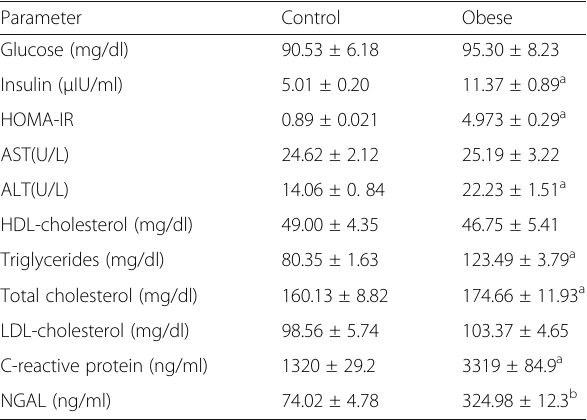
Table 2 Comparison of laboratory data between control and obese groups